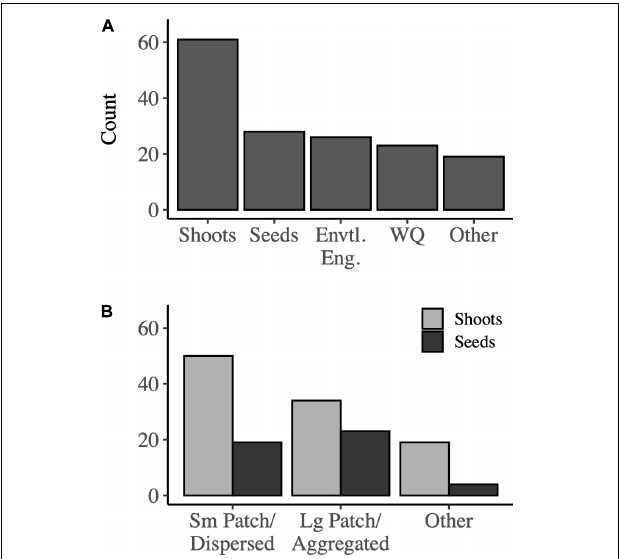
FIGURE 2 | Approaches to (A) seagrass restoration broadly, and (B) specific methodologies regarding planting configuration. Envtl. Eng. = Environmental engineering, and WQ = water quality. Other approaches included sediment filling and remediation, building breakwaters or living shorelines, and alteration of